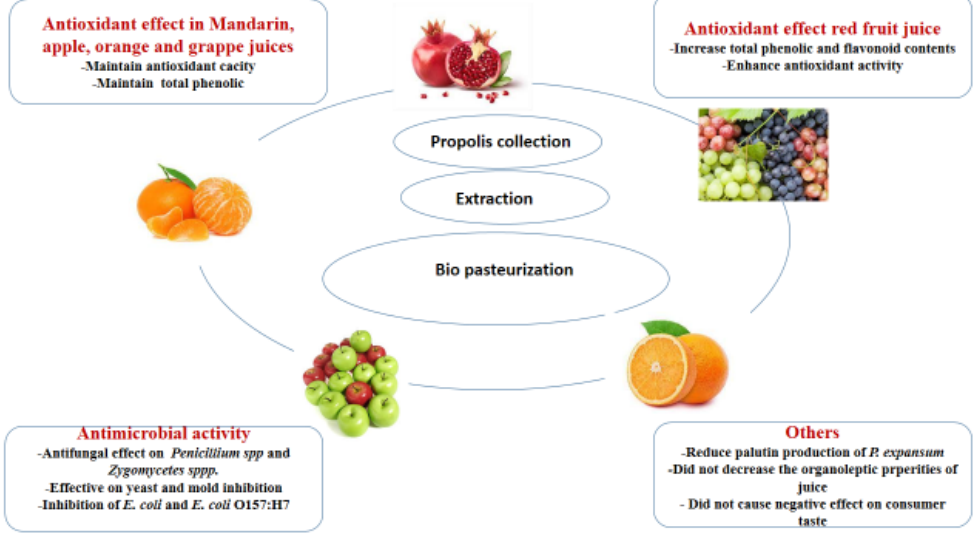
Figure 1. Effect of propolis on fruit juice